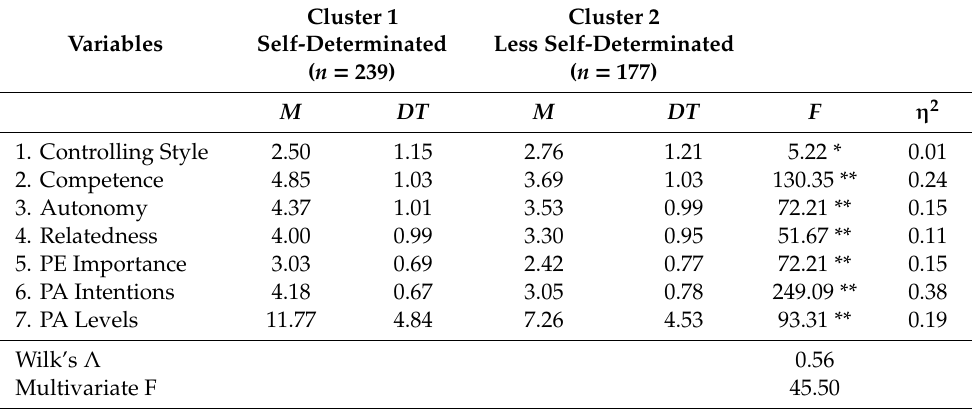
Table 4. Multivariate